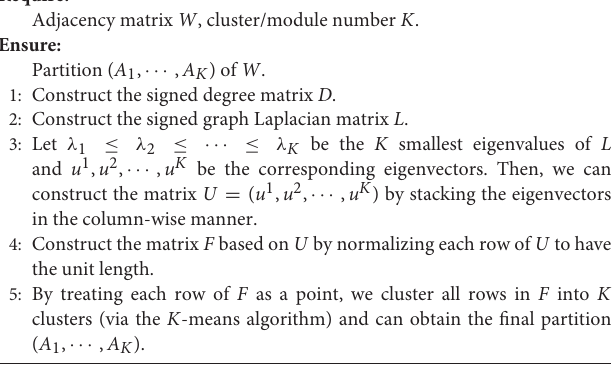
Algorithm 1 Algorithm of singed spectral